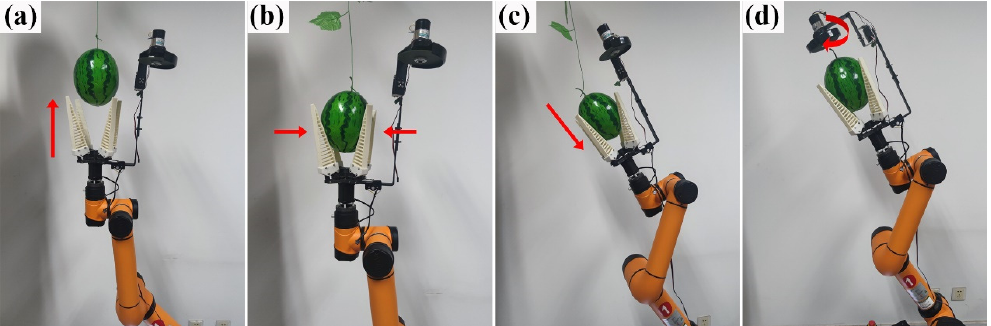
Figure 5. Operating process of the end-effector: ( a ) the end-effector reaches the pre-grasp position; ( b ) flexible fingers hold the watermelon tightly; ( c ) the end-effector drags the watermelon; ( d ) the cutting device trims the watermelon pedicel.